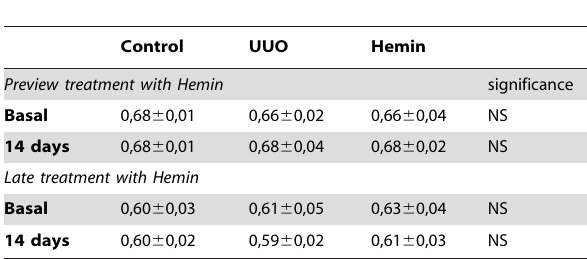
Table 1. UUO surgery does not alter serum creatinine values.